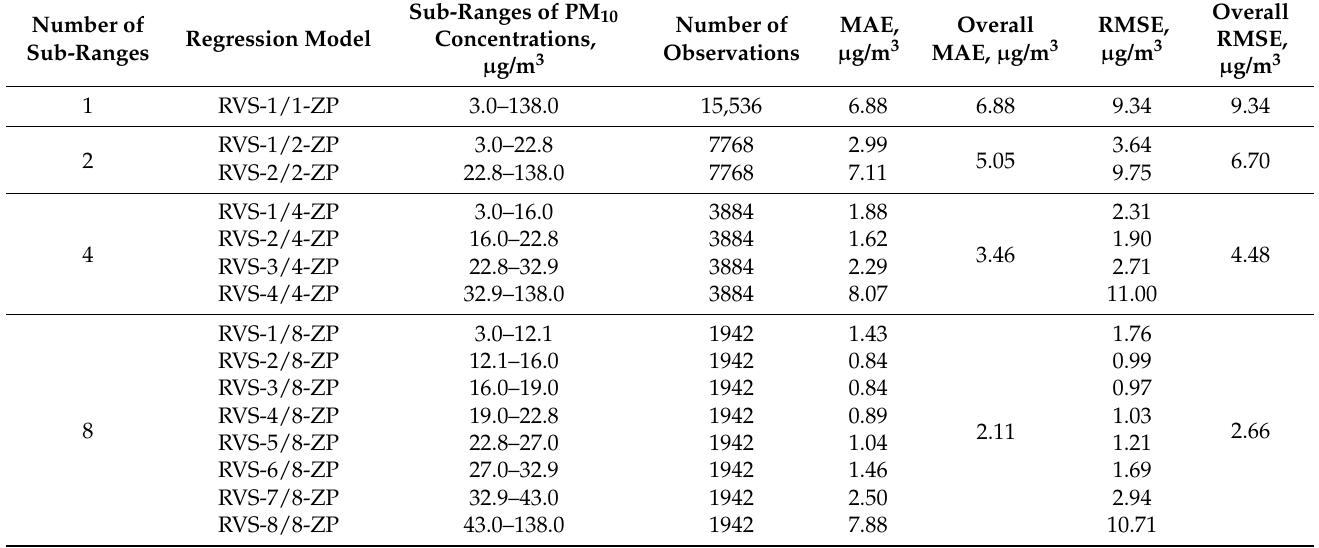
Table 22. Values of approximation errors of PM 10 concentrations in RVS models, Złoty Potok 2011–